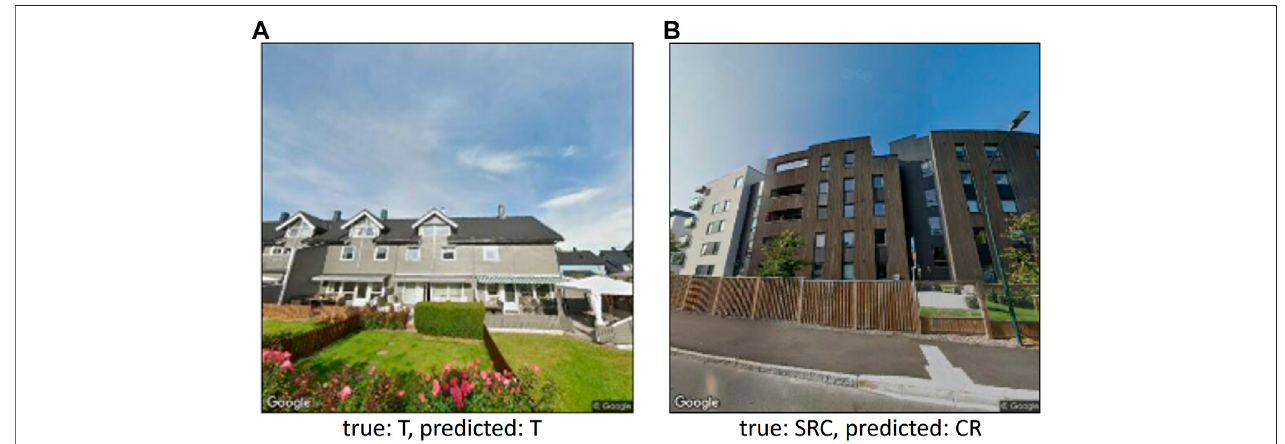
FIGURE 5 | Examples of correctly (A) and falsely (B) classi fi ed images.